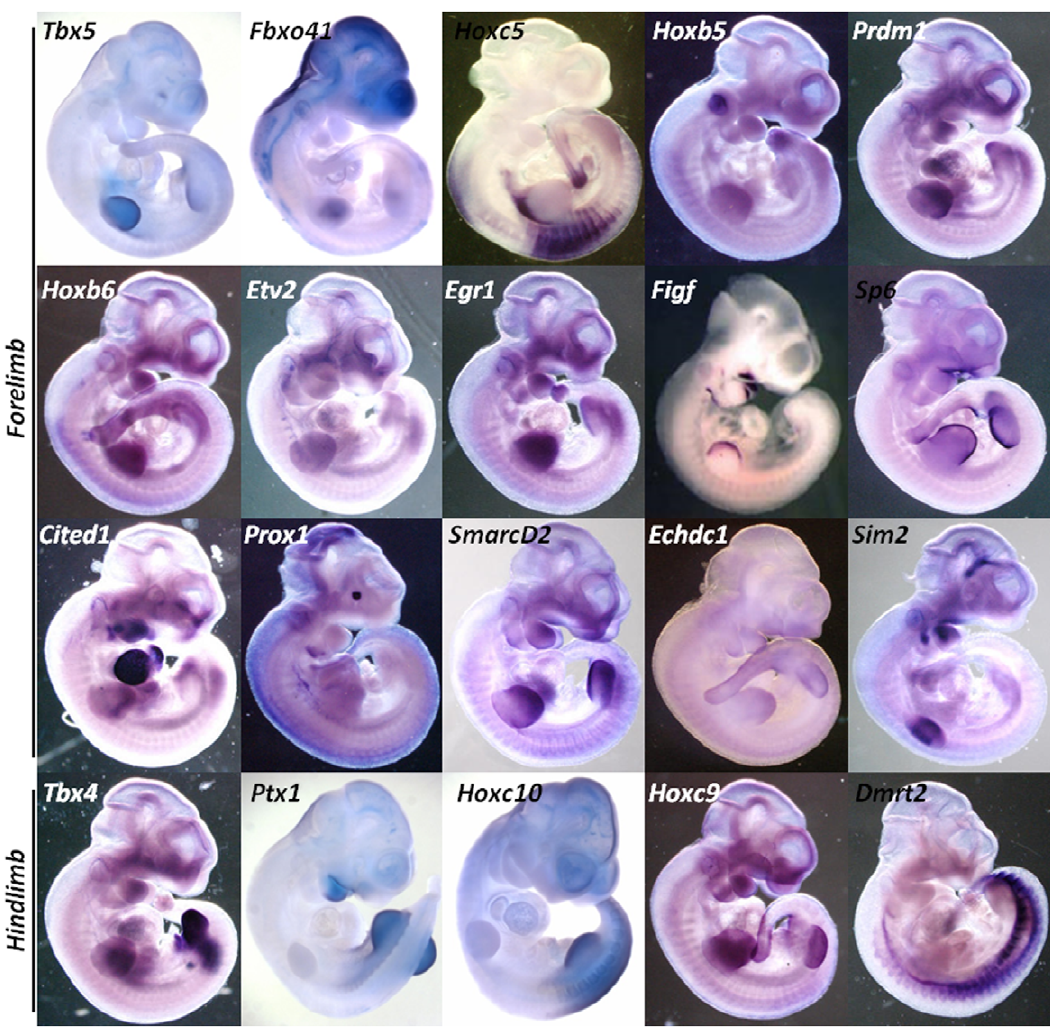
Figure 8. Expression Patterns of Fore- and Hind-limb Specific Genes. Qualitatively some genes identified as forelimb or hindlimb specific do not appear to be restricted to one limb such as Sp6 , SmarcD2 and Hoxc10 , yet quantitatively these transcripts are . 2 fold up-regulated in one limb in relationship to the other.